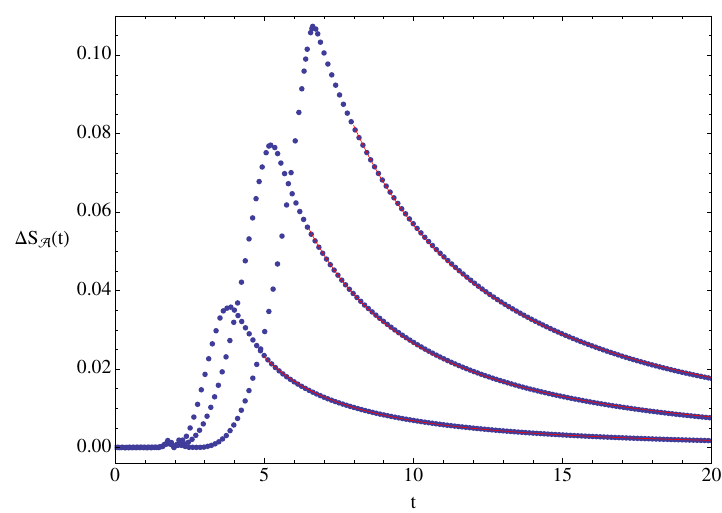
Figure 3 . The late-time behaviour of the entanglement entropy closely follows the logarithmic decay (3.7) for L = f 1 ; 2 ; 3 g , from top to bottom, for (cid:11) = 0 : 1, M = 0 : 01, (cid:27) = 2 and Q = 0 : 04. In this particular case, the best (cid:12)t exponents are, respectively, (cid:14) = f 1 : 36 ; 1 : 48 ; 1 : 49 g .